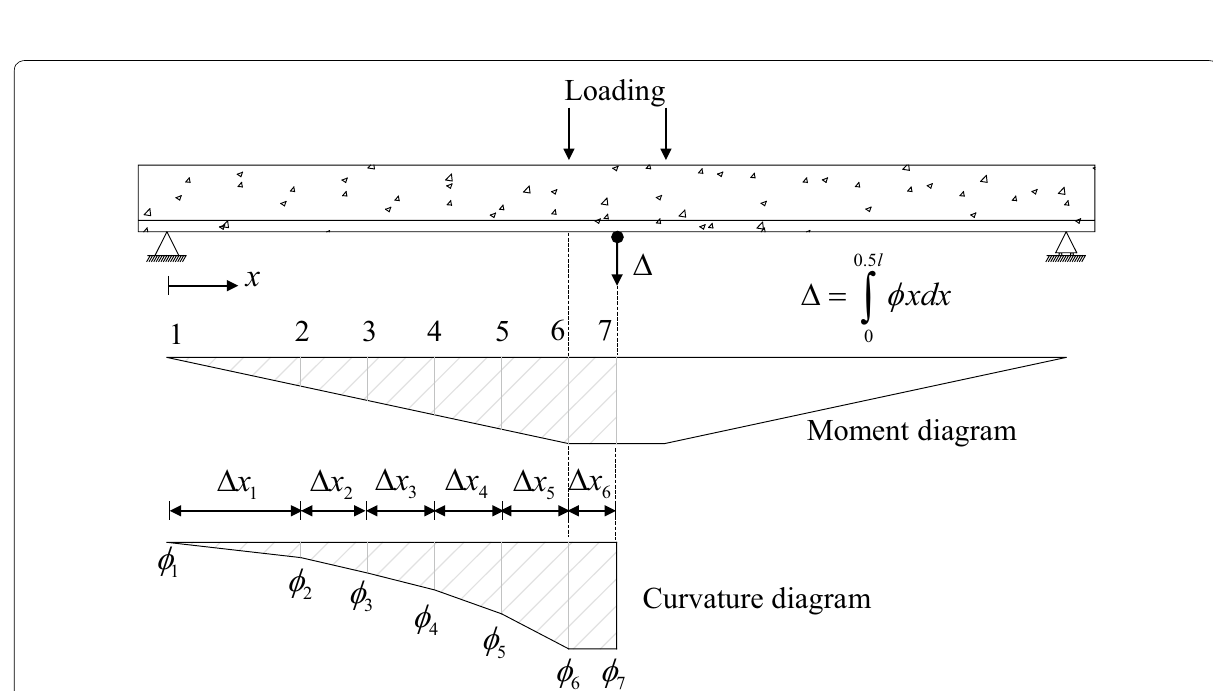
Fig. 14 Estimation of vertical deflection based on moment–curvature analysis